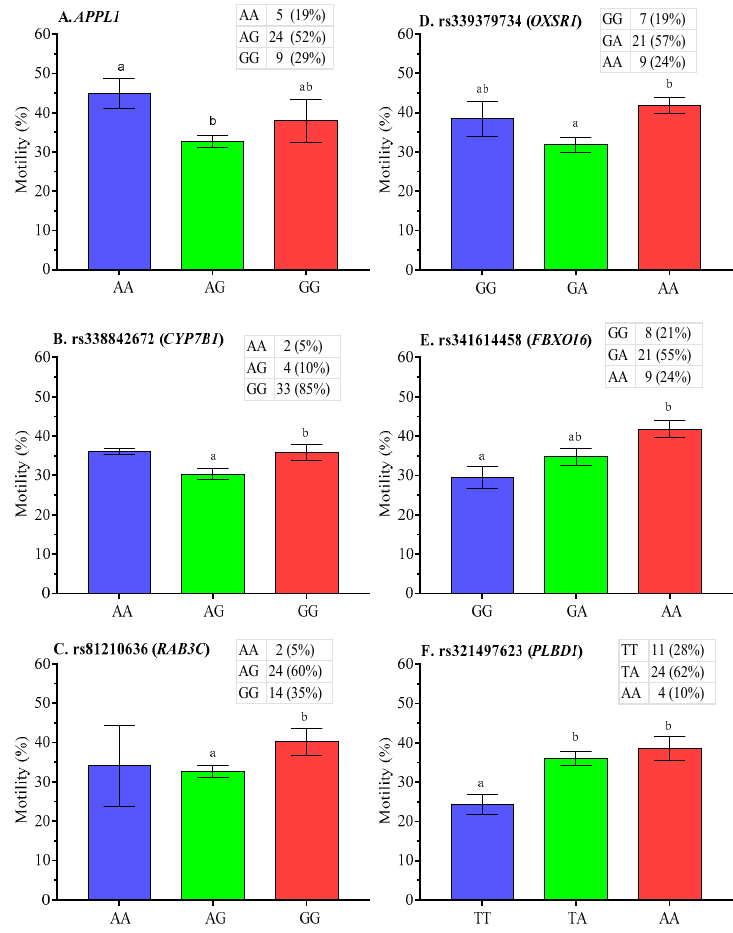
Figure 3. E ff ect of polymorphisms in A . APPL1 , B . CYP7B1 , C . RAB3C , D . OXSR1 , E . FBXO16 , and F . PLBD1 genes on post-thaw motility of boar spermatozoa. Data are presented as the mean ± SEM; a,b Di ff erences between genotypes were significantly di ff ered at p < 0.05. Significantly lower ( p < 0.05) post-thaw MMP (Figure 4A), PMI (Figure 4B), and acrosome integrity (Figure 4C) were concurrent with higher post-thaw LPO for TT genotype at rs321497623 (Figure